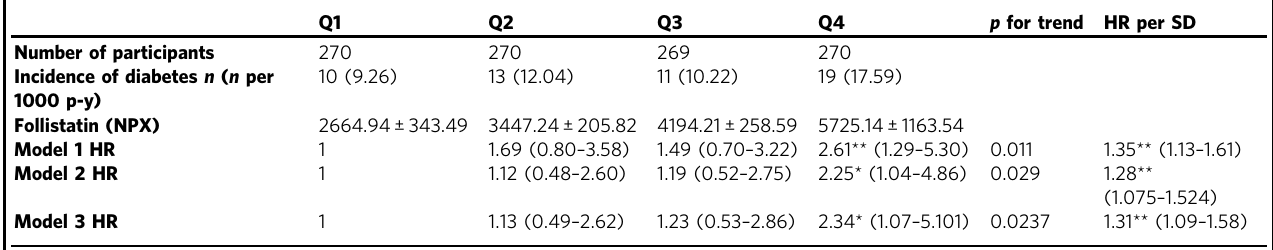
Table 4 Incidence of diabetes in relation to quartiles of follistatin in the IMI-DIRECT-METSIM cohort. The relationship between follistatin levels in plasma and incidence of diabetes during the follow up was explored in 1079 individuals, and fully-adjusted association study was performed in 883